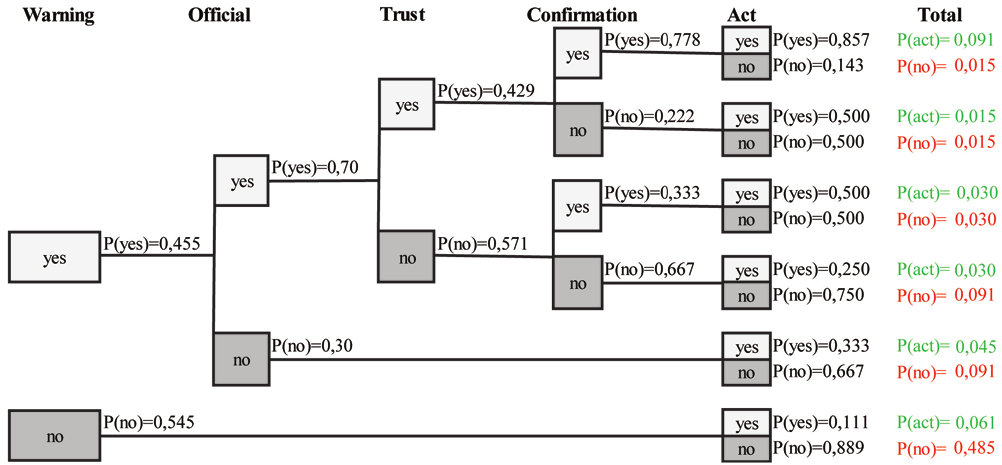
Fig. 3. Results of the 66 questionnaires.